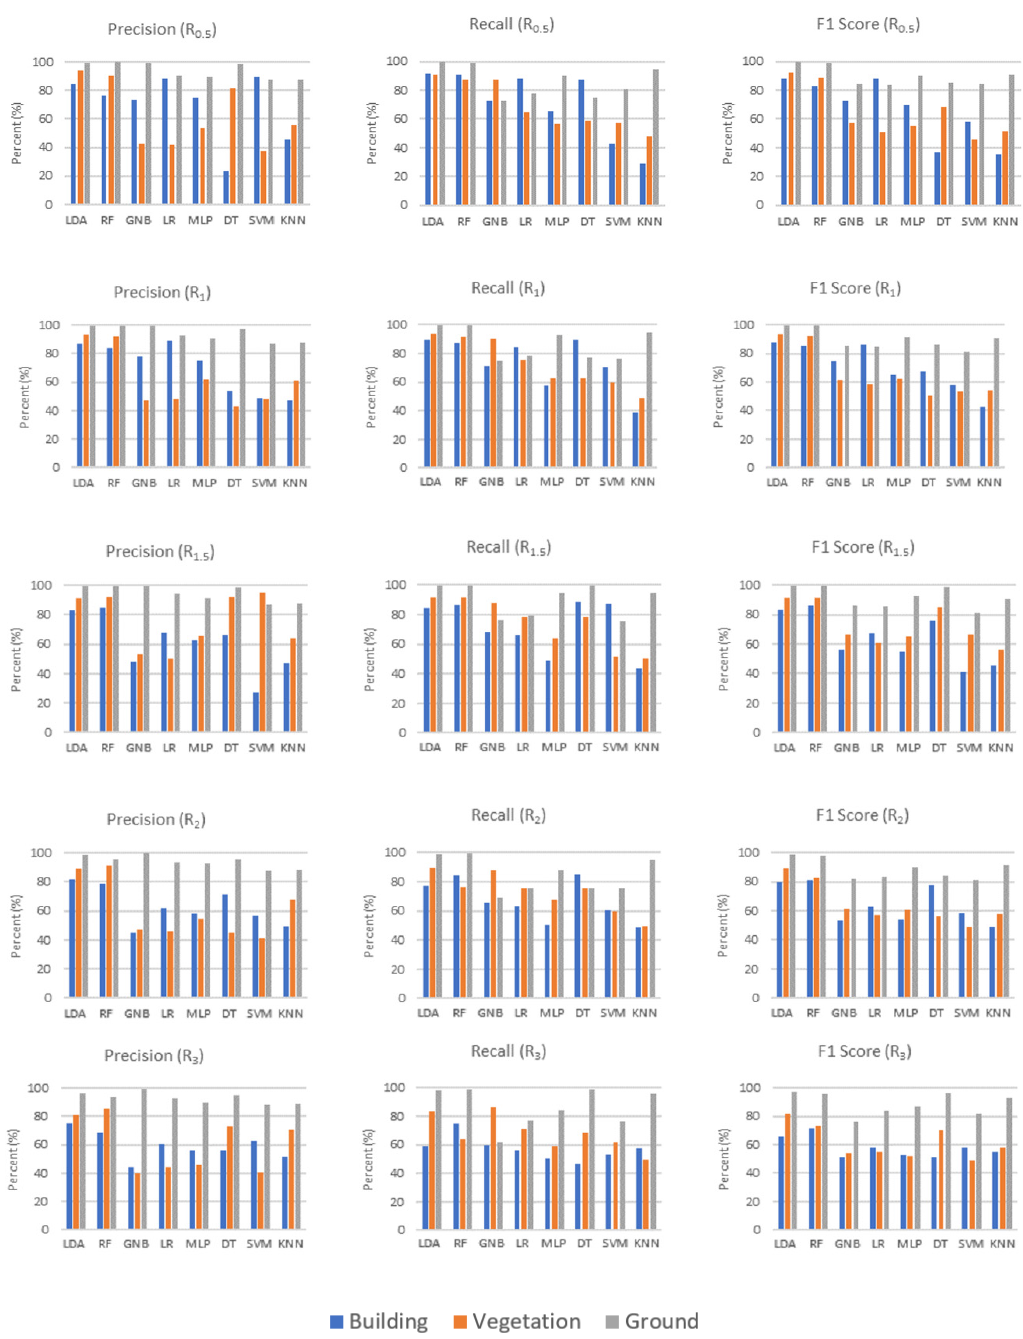
Figure 15. Precision, recall and F1 score values of the algorithms for the Oakland 3D dataset. Geometric features affected the accuracy at different rates. This situation was defined as feature importance. Some methods calculate the feature importance value. RF is a method to obtain an ordered list of them. The most important feature in both datasets was the Z coordinates of the points. Other important features for the Dublin City dataset were verticality and volume density. The least important feature was linearity. The roughness feature was also of low importance except for the R 3 support. In the Vaihingen dataset, verticality was the second most important feature. While the least important feature was Linearity, the importance of roughness increased as the support radius grew. Since most of the values were obtained as NaN, no evaluation was made for R 0.5 in the Vaihingen dataset. Feature importance values calculated for each study area were presented in Figure 16.